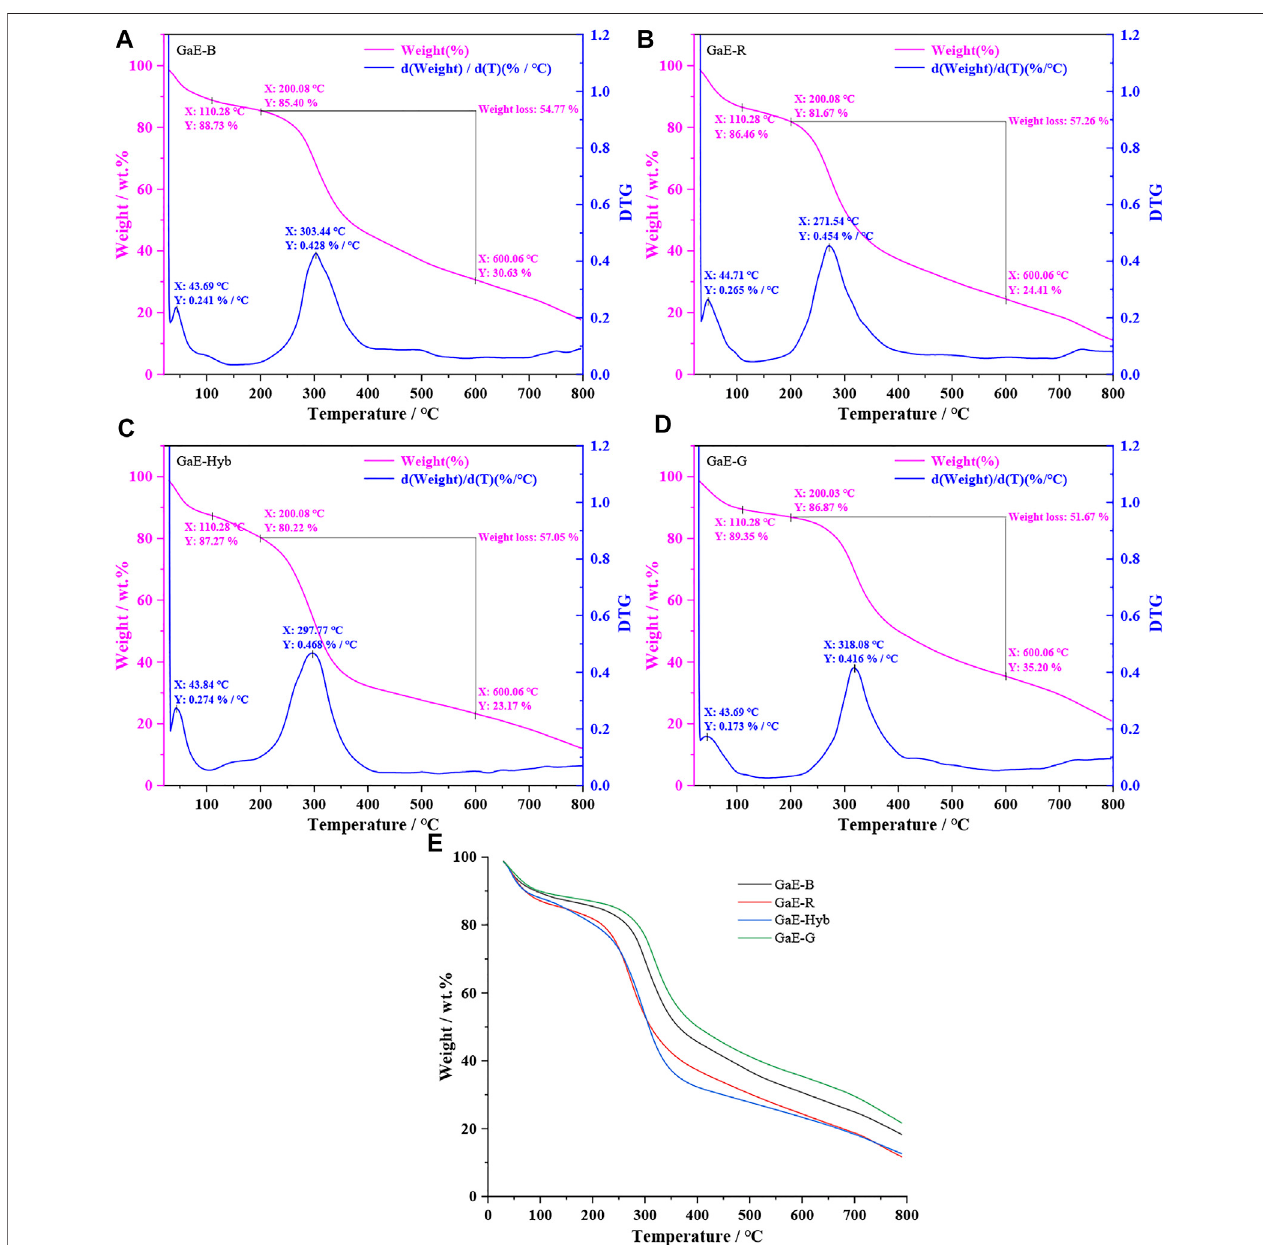
FIGURE4| TGAthermogramof Gastrodiaelata withfourdifferentvarieties. (A) GaE-B; (B) GaE-R; (C) GaE-Hyb; (D) GaE-G;and (E) thefourvarietiesof Gastrodia elata .